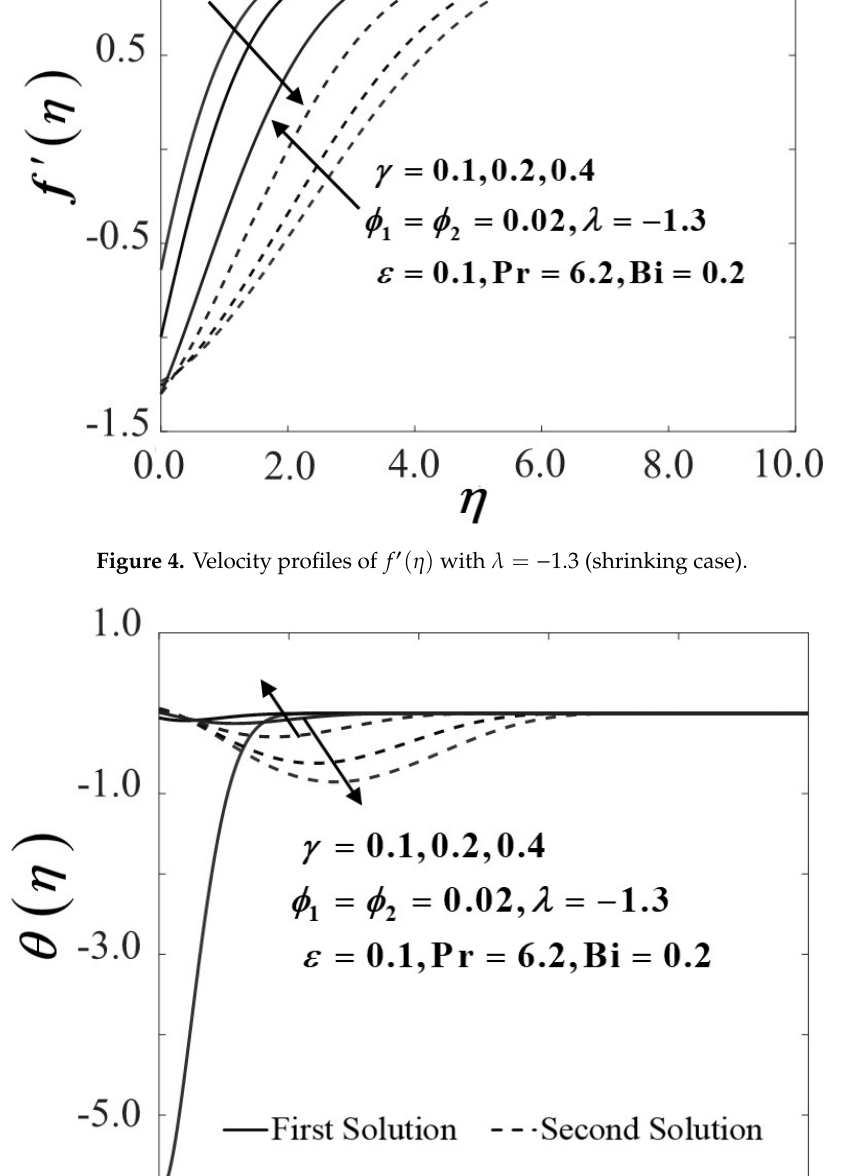
( ) θη with 1.3 λ = − (shrinking case).